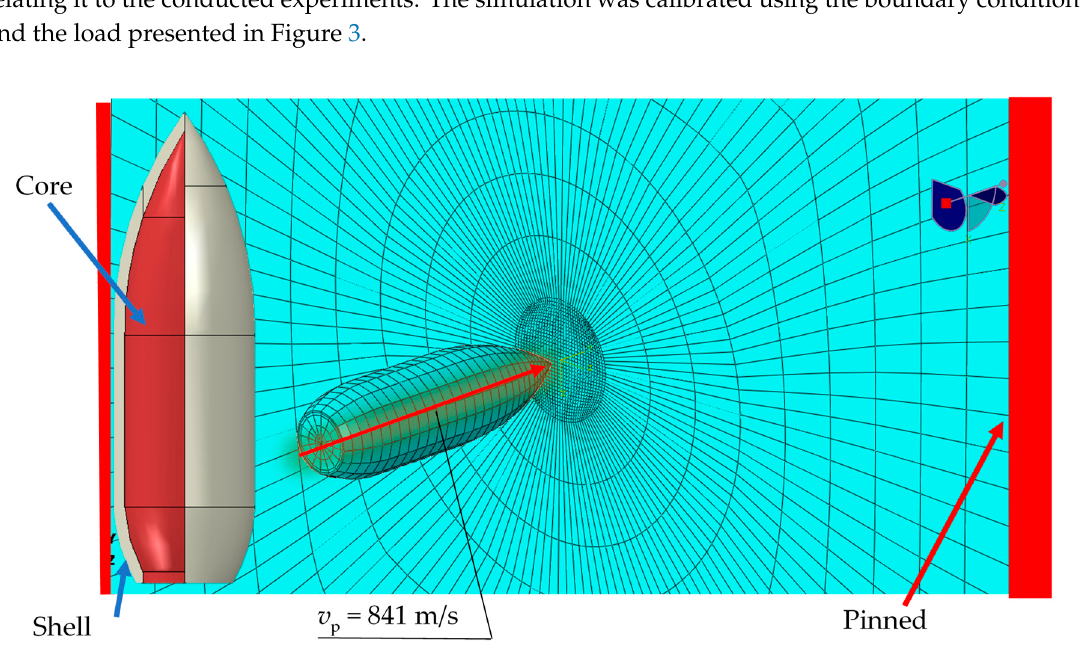
Figure 3. Geometry and discretization of the projectile and the sample [7].